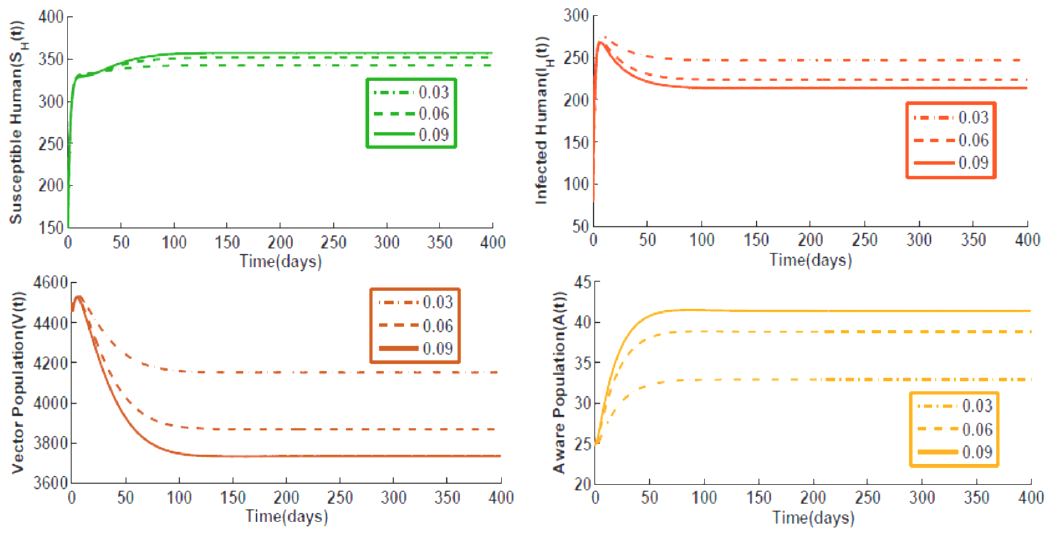
Fig. 5. Density of four populations for different values of 𝑘